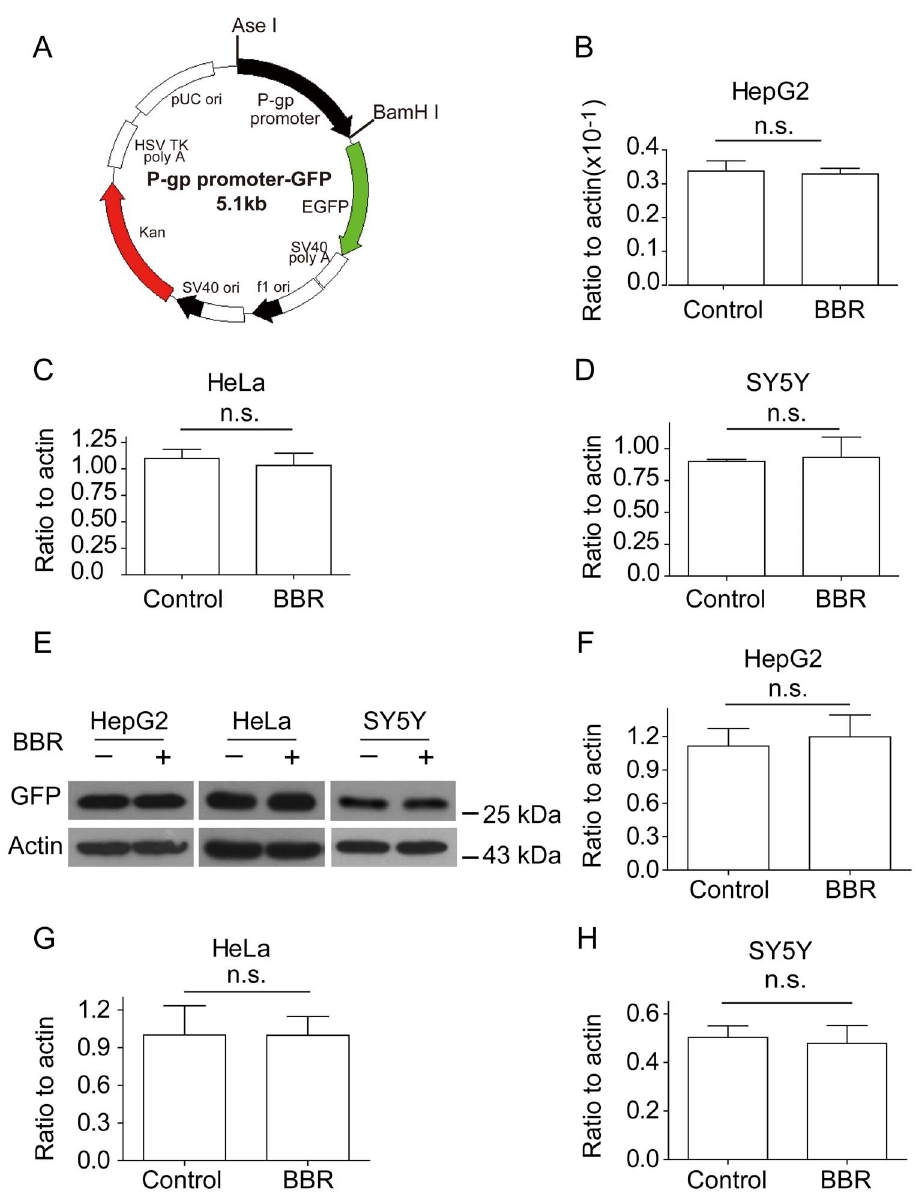
Figure 7. BBR does not act on P-gp promoter. (A) Schematic map of P-gp 1 kb promoter fused GFP (P-gp promoter-GFP) construct. Black, P-gp promoter. Green, reading frame of EGFP. (B–D) mRNA expressions of P-gp 1 kb promoter fused GFP in the presence or absence of BBR by real-time PCR assay. (B), HepG2; (C), HeLa; (D), SY5Y. (E) Western blotting assay showed changes of P-gp 1 kb promoter fused GFP protein with BBR treatment. (F–H) The ratio changes of GFP versus b -actin. Data are presented as mean 6 S.D. from 3 independent experiments (n=3). ‘‘ n.s.’’ means no statistical significance.